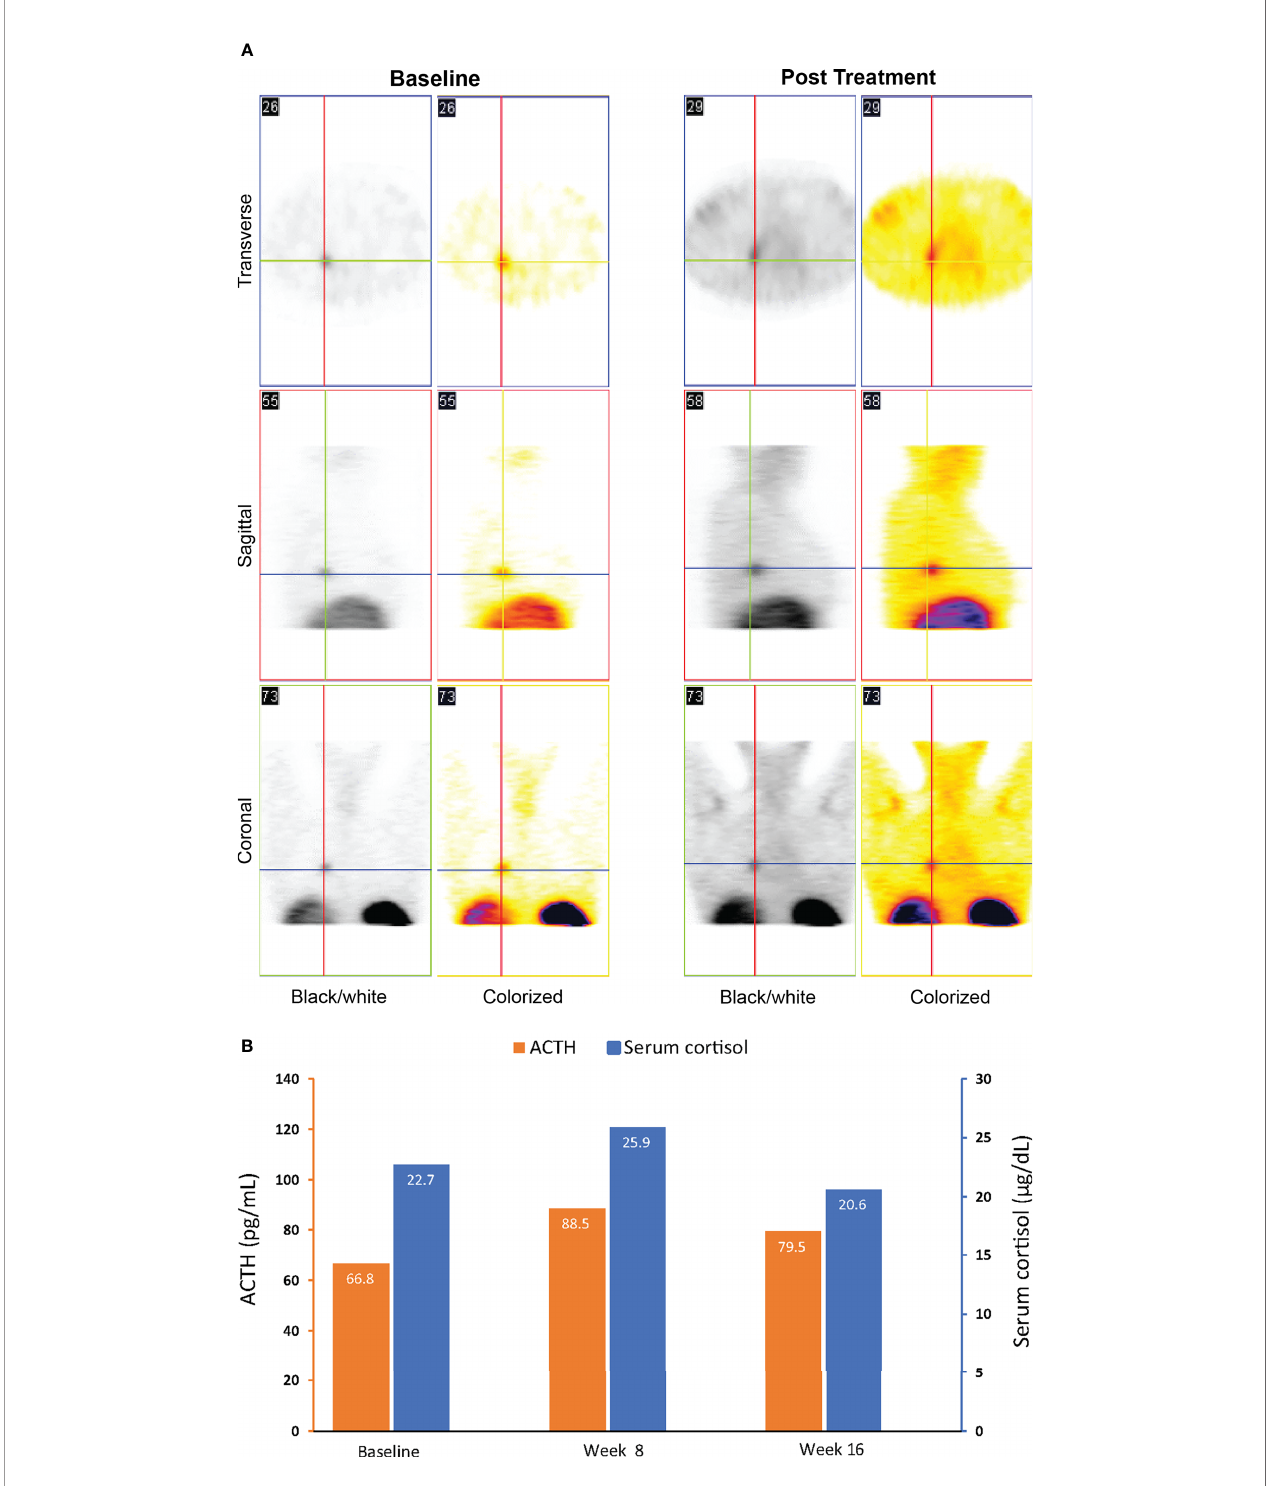
FIGURE 3 | Imaging (A) and ACTH and cortisol levels (B) for case 1: a 46-year-old woman with an ectopic ACTH-secreting tumor (ectopic Cushing syndrome) treated with relacorilant for 16 weeks. (A) Octreotide scintigraphy. Increased uptake on post treatment imaging was consistent with increased expression of SSTR2s following treatment with relacorilant. (B) ACTH and cortisol levels before (baseline) and during relacorilant treatment. Normal laboratory ranges: ACTH, 6.0-50 pg/mL; serum cortisol, 4.6-20.6 µg/dL. To convert ACTH values from pg/mL to pmol/L, multiply by 0.22. To convert serum cortisol from µg/dL to nmol/L, multiply by 27.6. ACTH, adrenocorticotropic